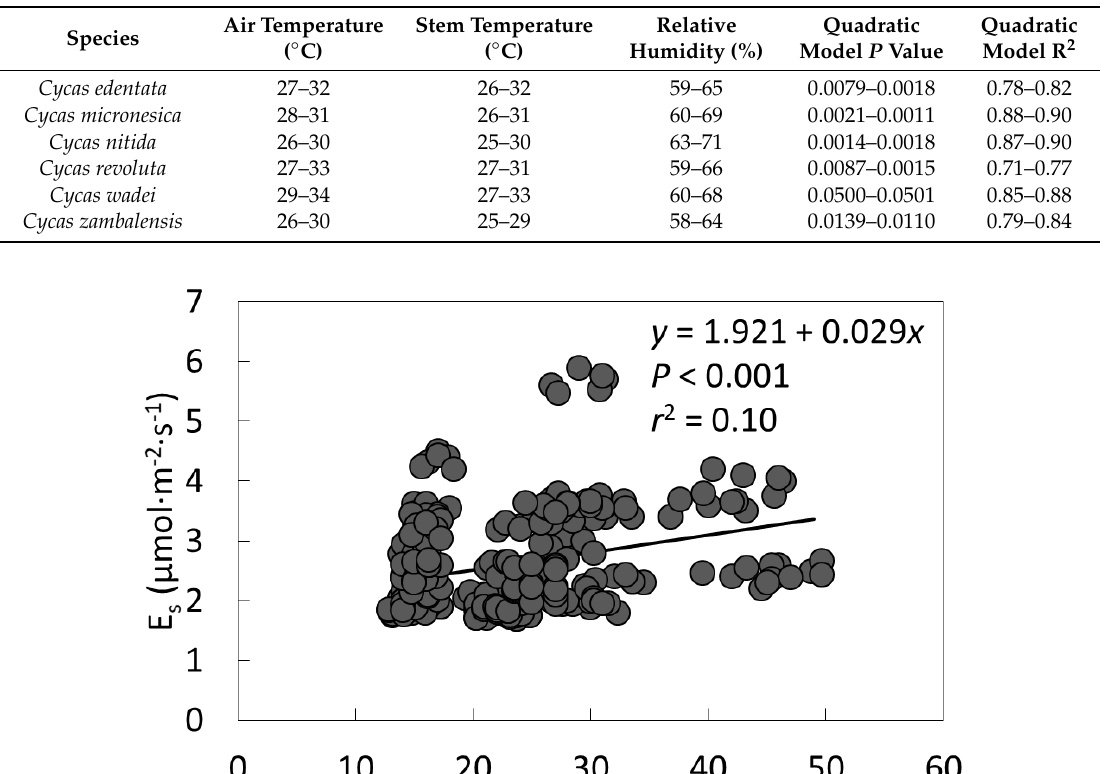
Table 1. Characteristics of the six study locations used for Cycas stem carbon dioxide efflux measurements. Range of six replications.